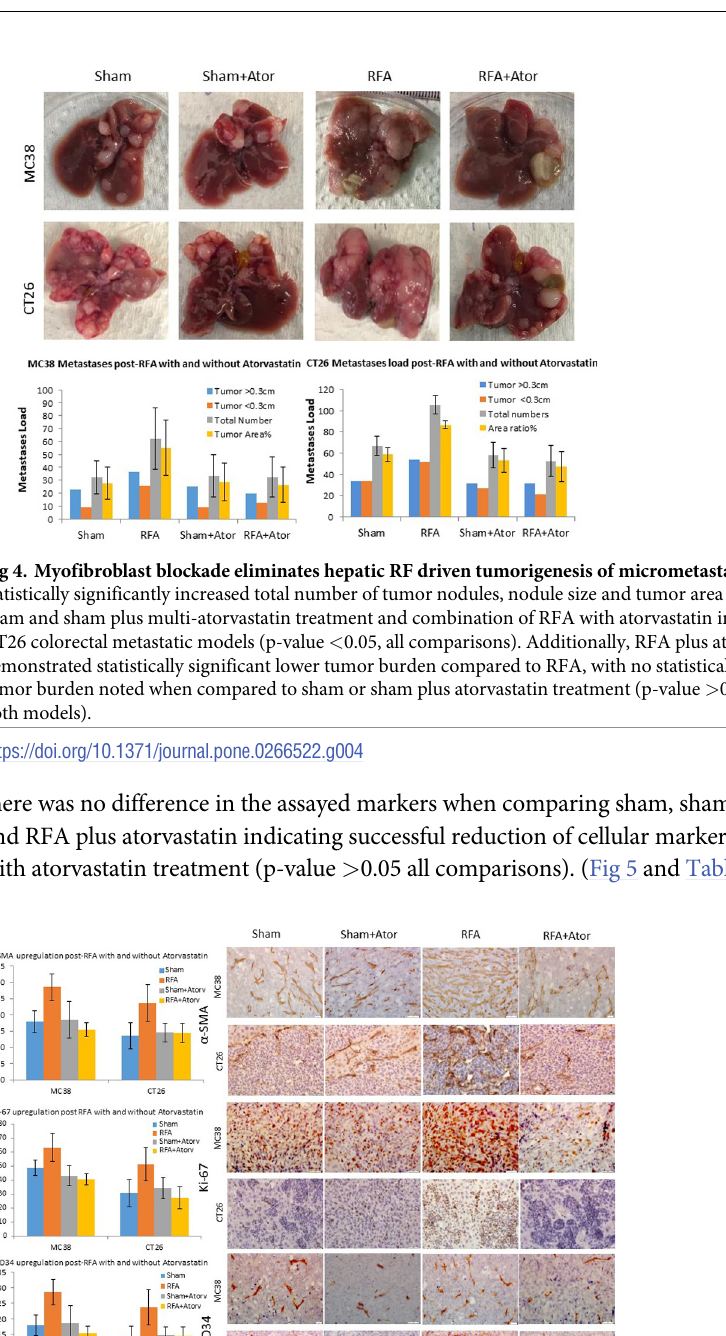
Fig 5. Myofibroblast blockade suppresses RF induced tumor proliferation of micrometastatic implants in murine colorectal cancer models. Immunohistochemical analysis of MC38 and CT26 demonstrated increased infiltration of activated myofibroblasts, increased cell proliferative indices and microvascular density in RFA groups when compared to sham, sham plus atorvastatin and RFA plus atorvastatin (p-value < 0.001 for all comparisons, for both models). Myofibroblast infiltration levels were reduced to baseline control groups’ levels in RFA with atorvastatin (p-value > 0.05 for all comparisons, for both models). Likewise, RFA also demonstrated increased Ki-67 and CD34 signals in metastatic nodules compared to sham, sham plus atorvastatin and RFA with atorvastatin (p-value < 0.001, all comparisons, both models), which were reduced to baseline levels in RFA plus atorvastatin treatment (p-value > 0.05 all